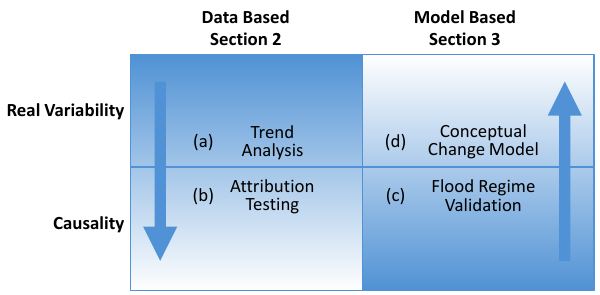
Figure 11. Synthesis of approaches to analysing flood regime changes. Dark blue shading indicates the current strengths of the data-based (change detection) and model-based (scenario) ap- proaches, light blue shading indicates future opportunities for these methods with regard to their current ability to represent causalities and variabilities. The proposed synthesis items (a) – (d) correspond to Sects.